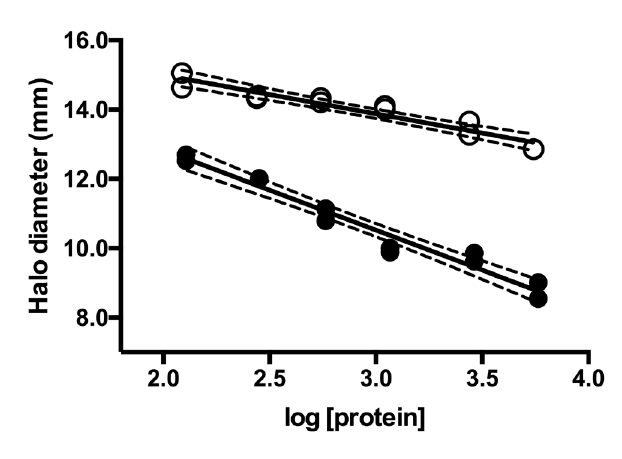
Figure 1. Inhibition curves of PLA2 activity of C. d. terrificus venom by the blood plasma of Boa constrictor (white dots). The blood plasma of C. d. terrificus was used as reference (black dots). Curve equations: y = (–1.112 ± 0.1075)x + (17.22 ± 0.3193) for B. constrictor and y = (–2.307 ± 0.1498) x + (17.45 ± 0.4478) for C. d. terrificus , with determination coefficient (R 2 ) of 0.9145 and 0.9546, respectively. The 95% confidence intervals of the best fit curves are indicated by dashed